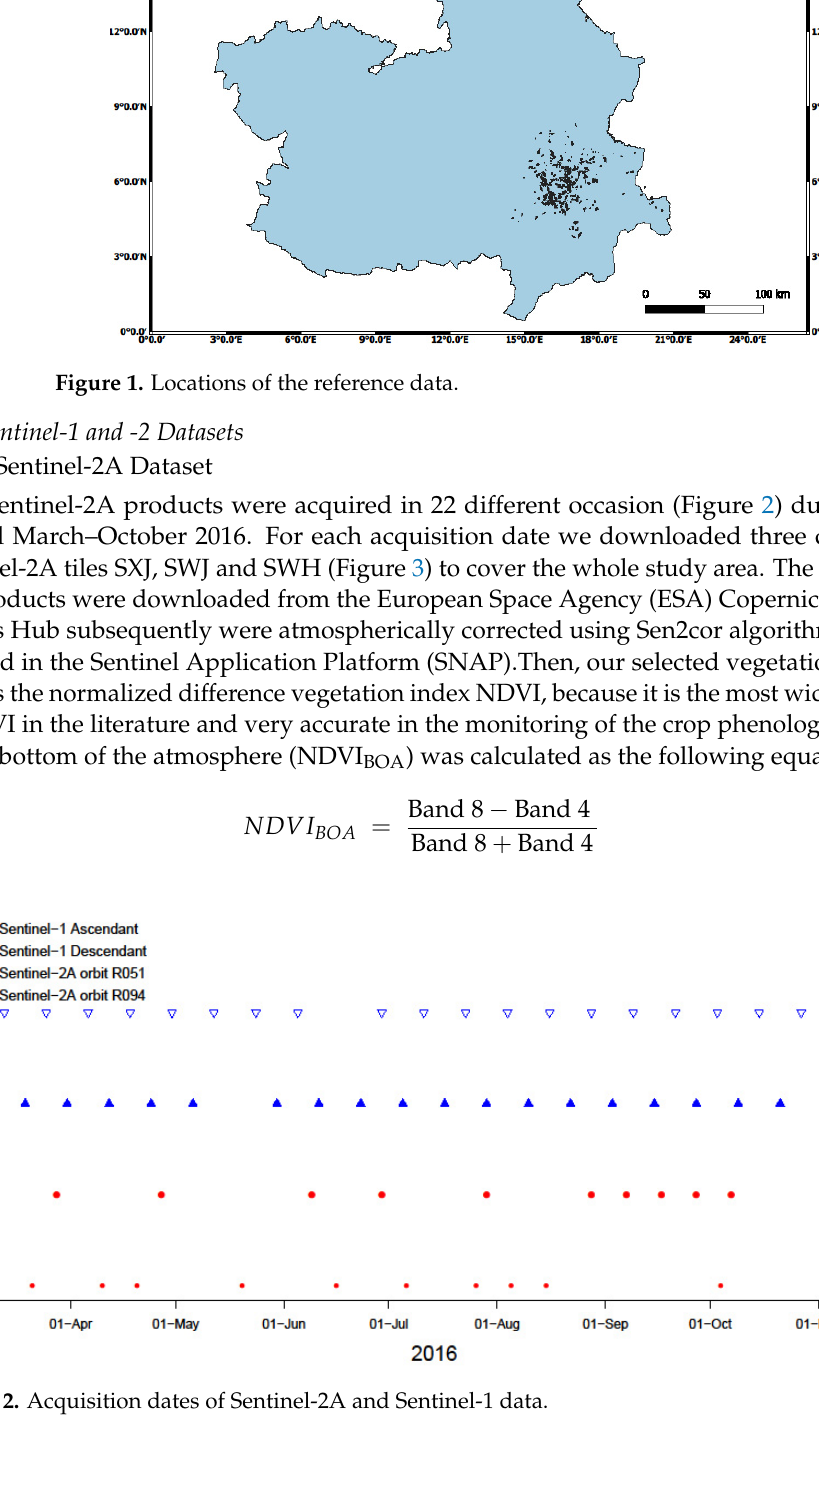
Figure 3. A zoomed normalized difference vegetation index (NDVI) scene composed by three Sentinel-2A tiles SXJ, SWJ, and SWH (obtained in 2016.03.05) over the study area. 2.2.2. Sentinel-1A Dataset A total of 39 Sentinel-1 images were acquired between March and October 2016 (Figure 2). The Sentinel-1 dataset comprises Level-1 Ground Range Detected (GRD) data in Interferometric Wide (IW) swath mode that was projected to ground range using the WGS84 Earth ellipsoid model. The resulting images in dual polarization (VH and VV) had dimensions of 270 × 270 km, resolution of 10 m, and temporal resolution of 6 to 12